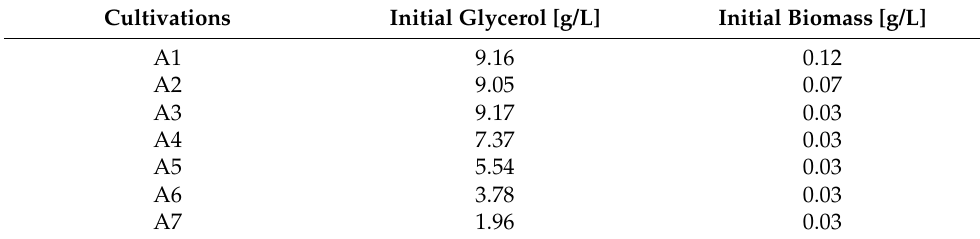
Table 1. Initial glycerol and biomass content of the cultivations.